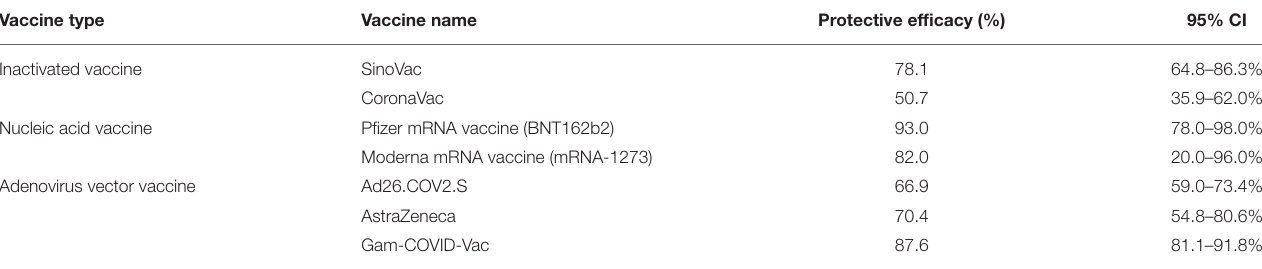
TABLE 4 | The protective efficacy of